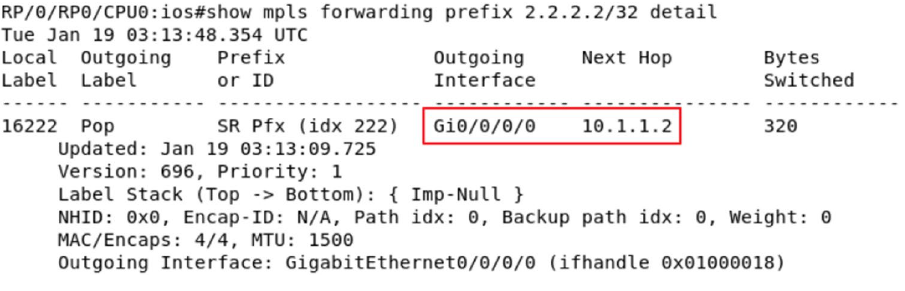
Figure 10. Original R1 device packet.